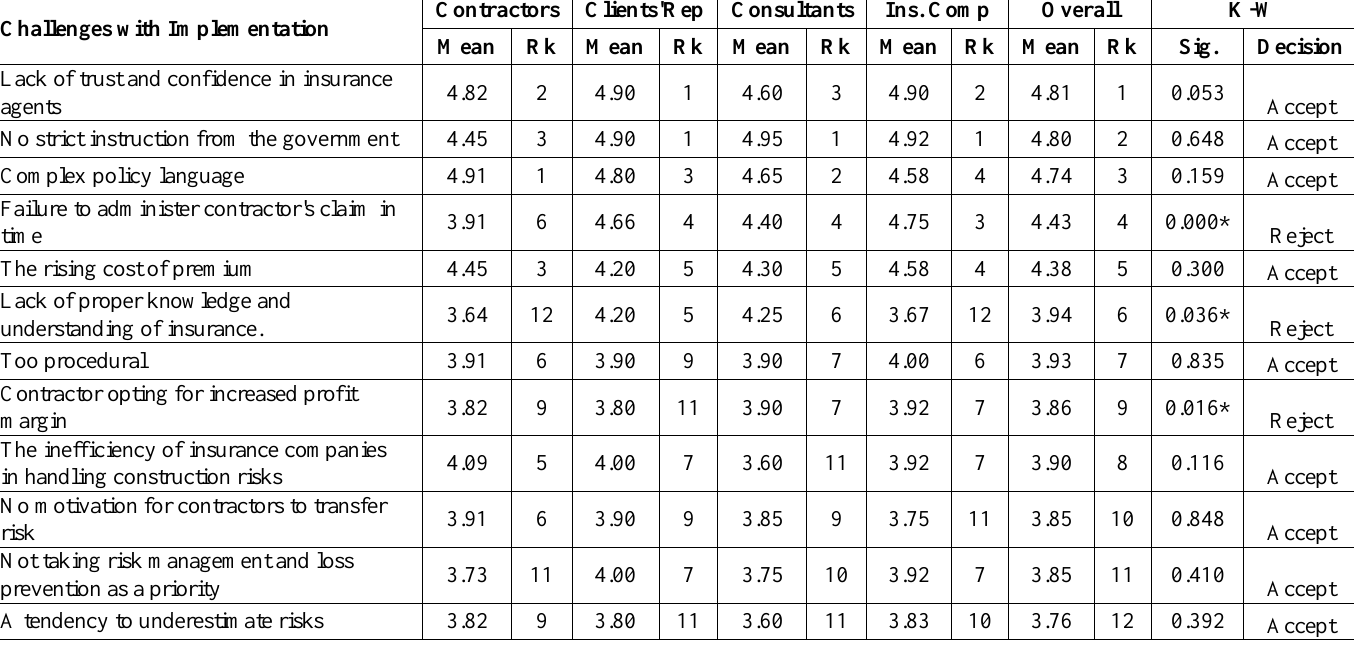
Table 3: Challenges Associated with the Implementation of Insurance in Building